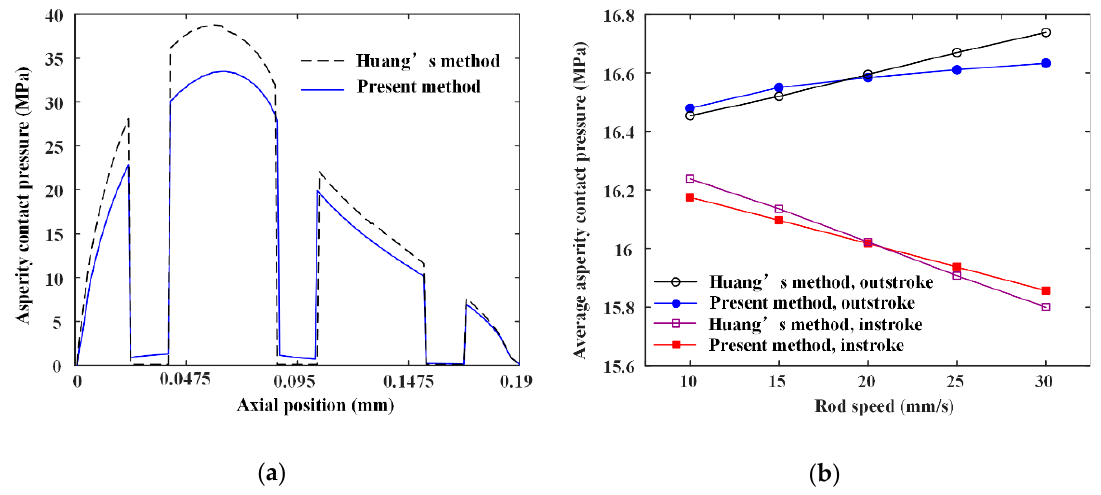
Figure 8. ( a ) Asperity pressure distributions comparison; ( b ) average asperity pressure comparison.